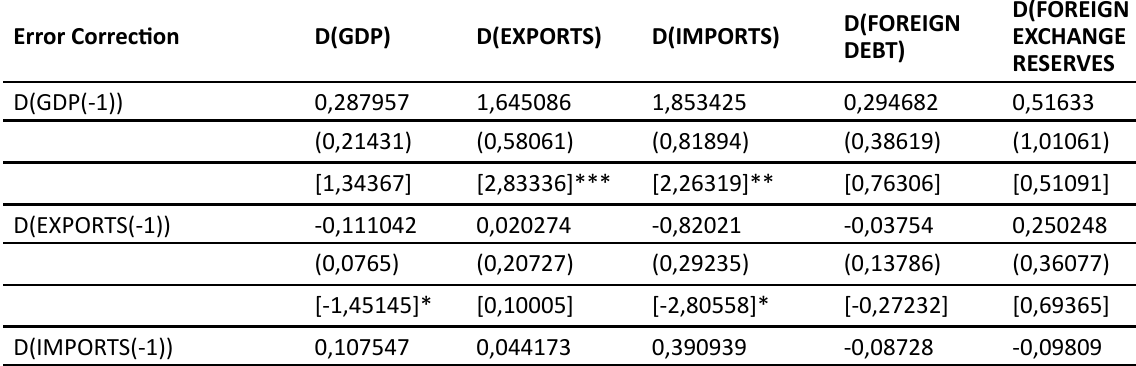
Table 5: Vector Error Correction